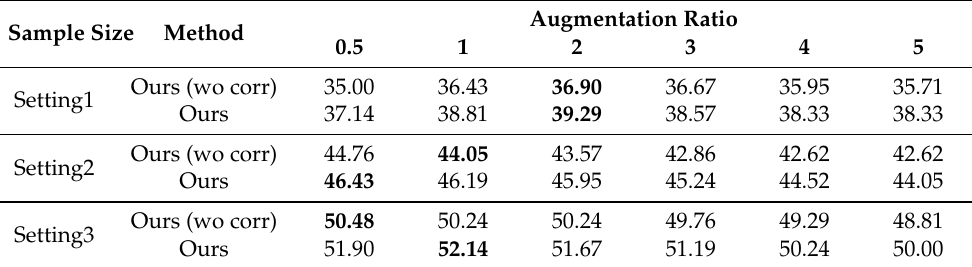
Table 6. Classification accuracy (%) with different augmentation ratios on the CMEW dataset. Best results are shown in